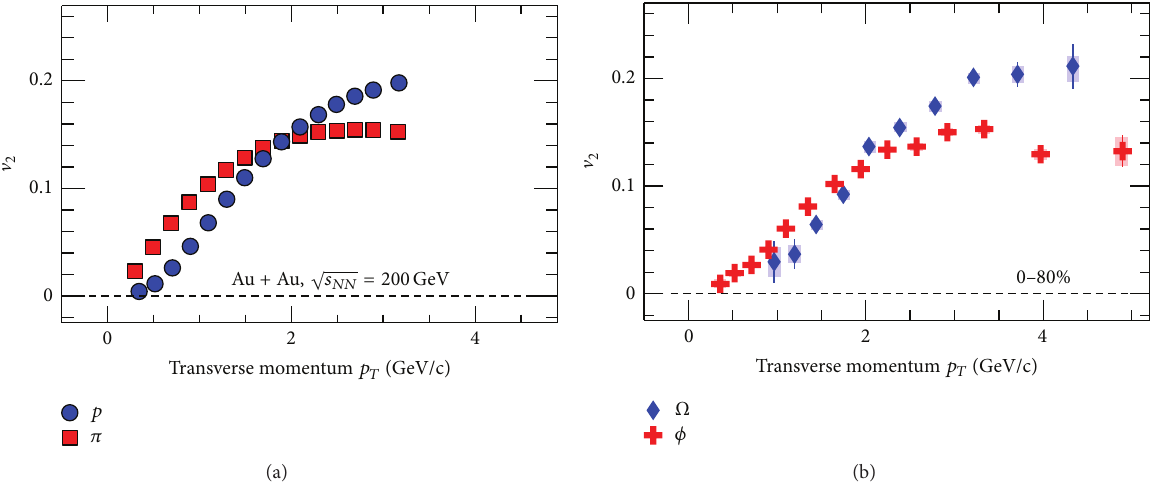
Figure 2: The V 2 as function of 𝑝 𝑇 for (a) 𝜋 and proton and (b) 𝜙 , Ω in Au + Au collisions at √𝑠 𝑁𝑁 = 200 GeV for 0–80% centrality [19].